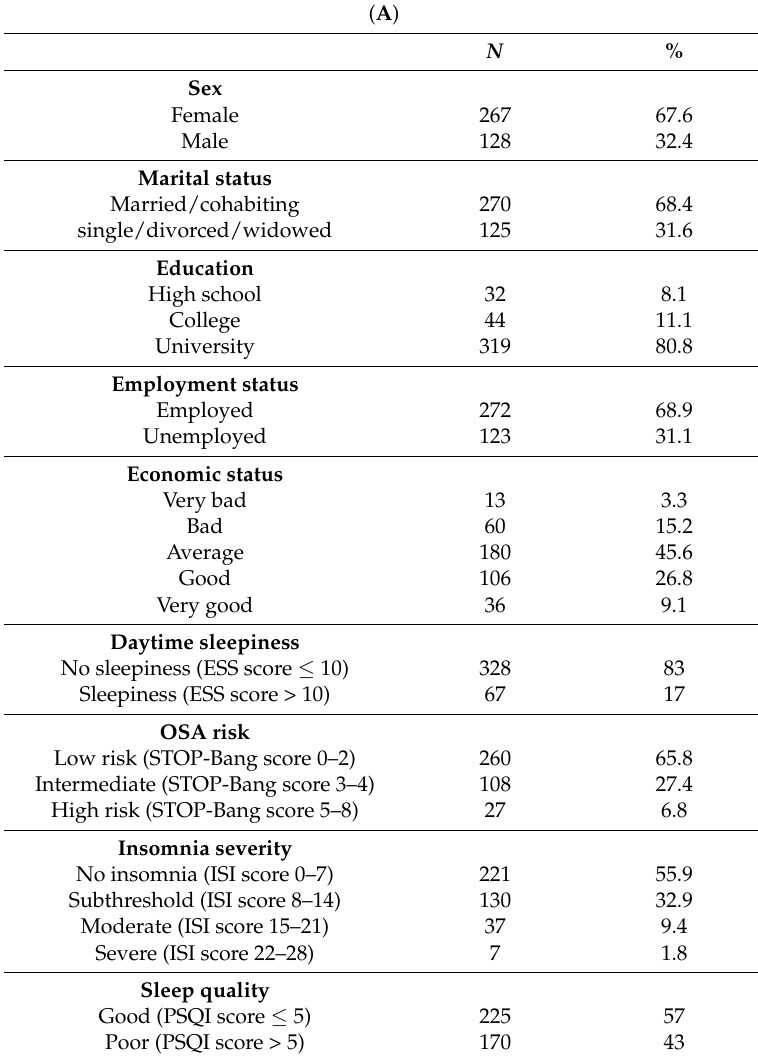
Table 1. Counts and percentages ( A ), and means and standard deviations ( B ) for demographic and health characteristics of the study